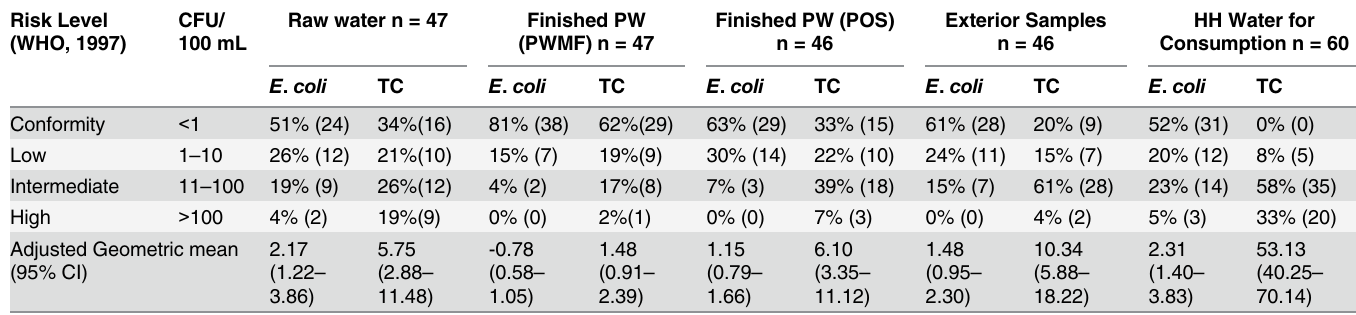
Table 1. Microbial results for raw, finished packaged sachet water (PSW) samples, and household stored water